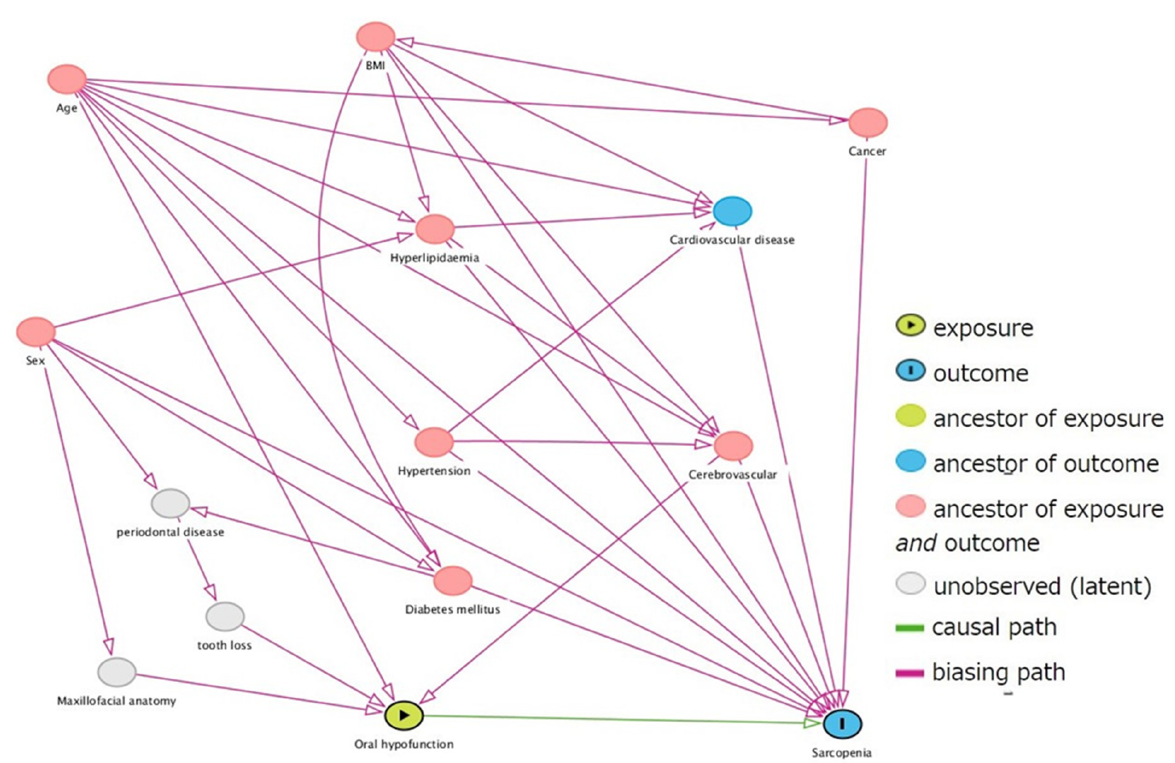
Figure 1. Selection of adjustment variables by directed acyclic graph.